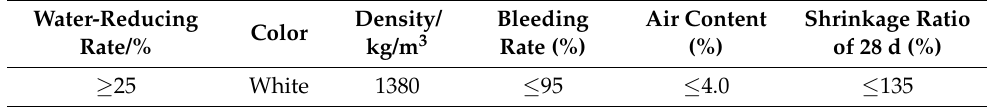
Table 3. Performance of water-reducing agent.